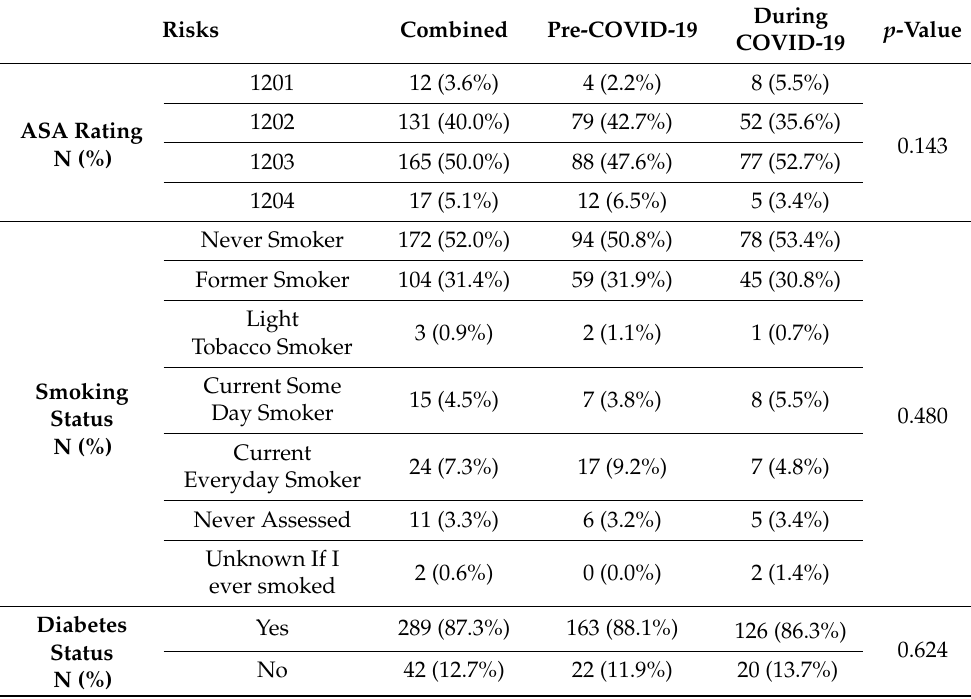
Table 2. Comparison of Surgical Risks Pre COVID-19 and During